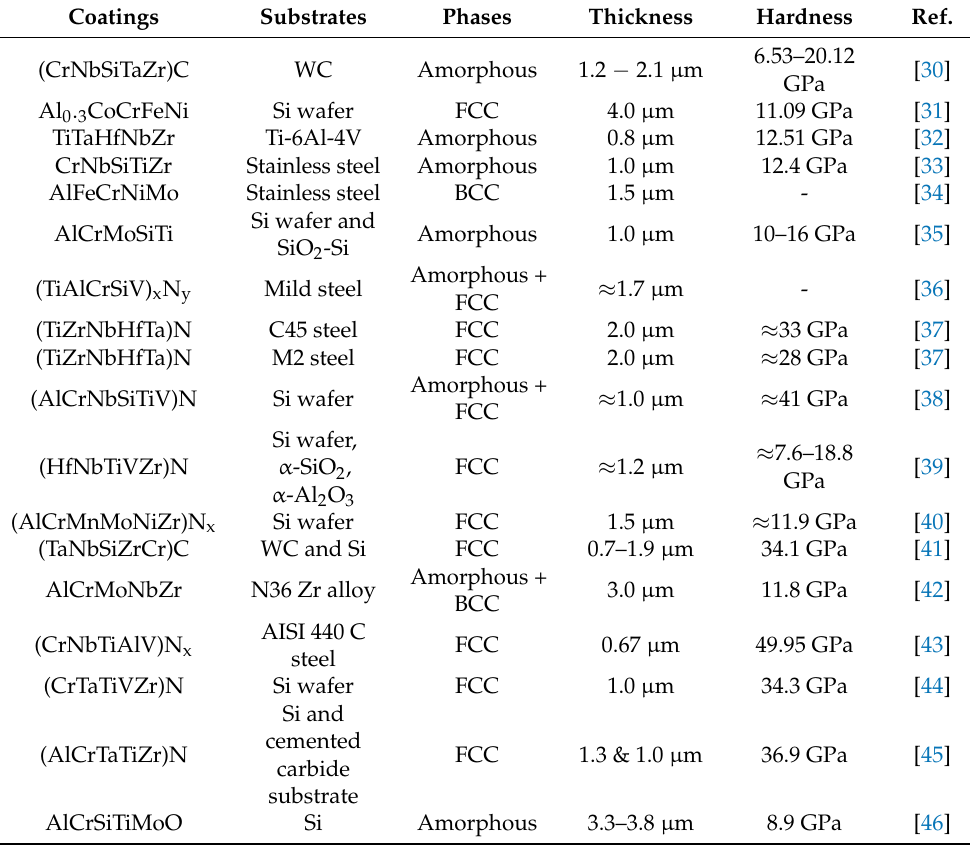
Table 2. The details about HEA-based coatings fabricated using magnetron